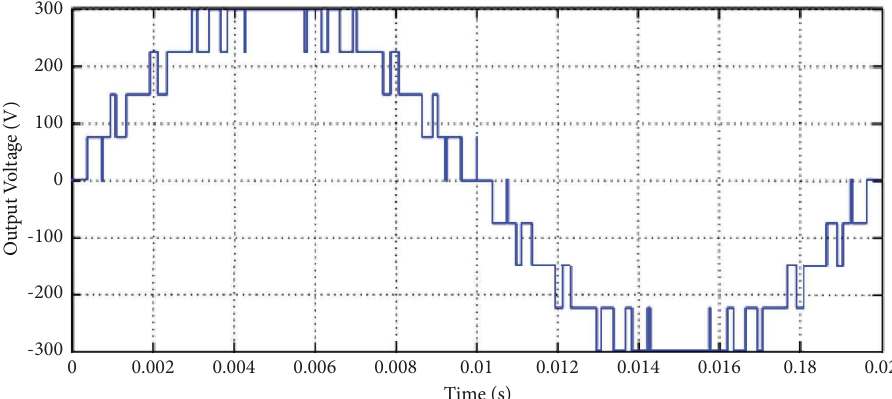
Figure 14: Output voltage of proposed 9-level inverter for R - L load.